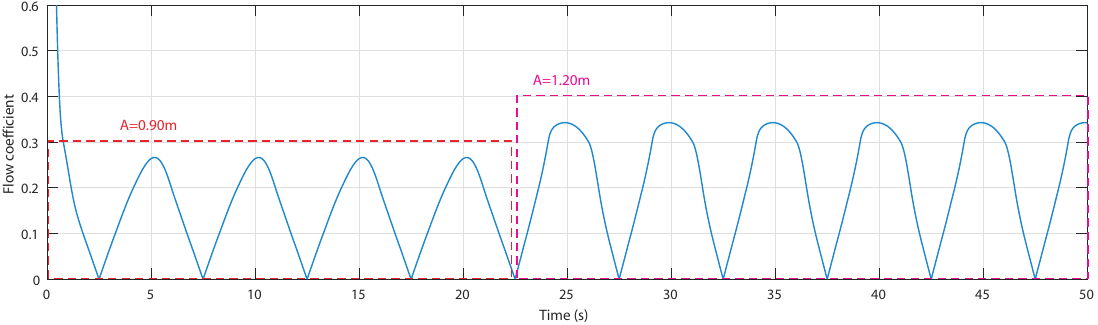
Figure 5. Flow coefficient vs. time for two wave amplitudes [27].